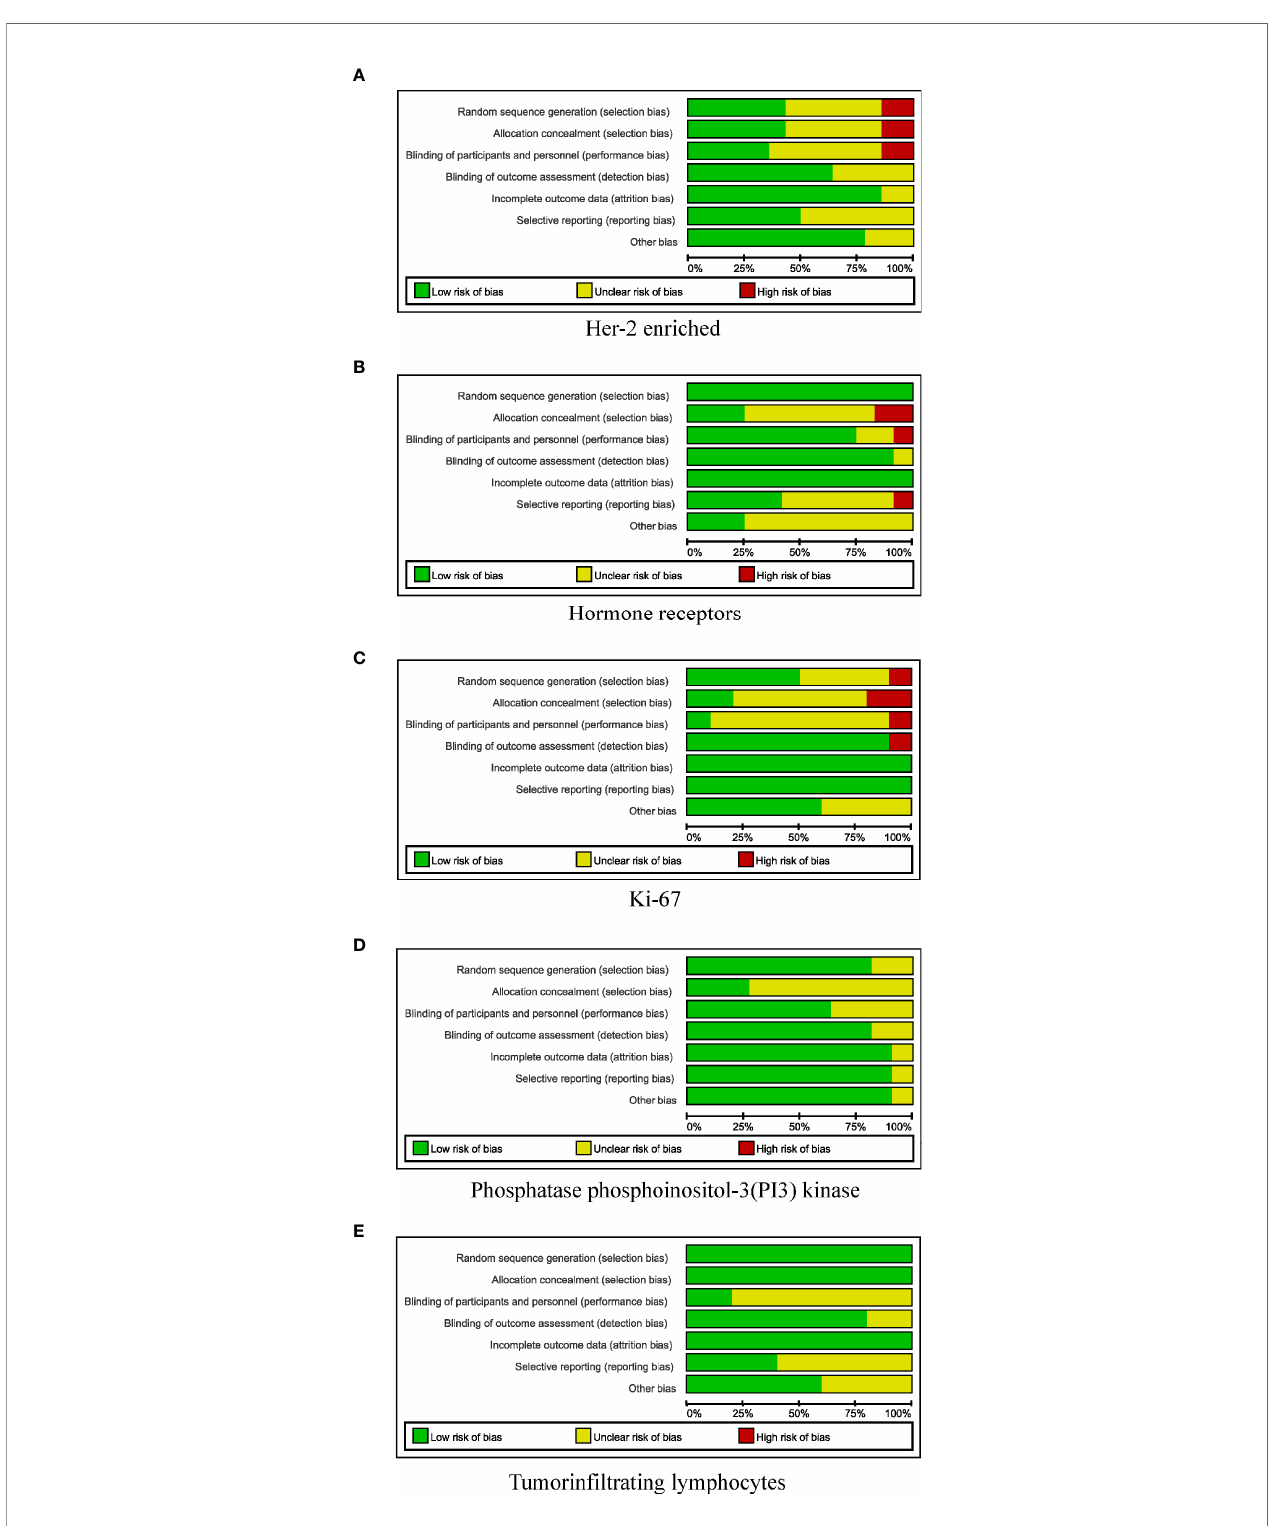
FIGURE 2 | Risk-of-bias review of all included studies. (A) HER-2 enriched. (B) Hormone receptors. (C) Ki-67. (D) Phosphatase phosphoinositol-3 (PI3) kinase. (E) Tumor-in fi ltrating